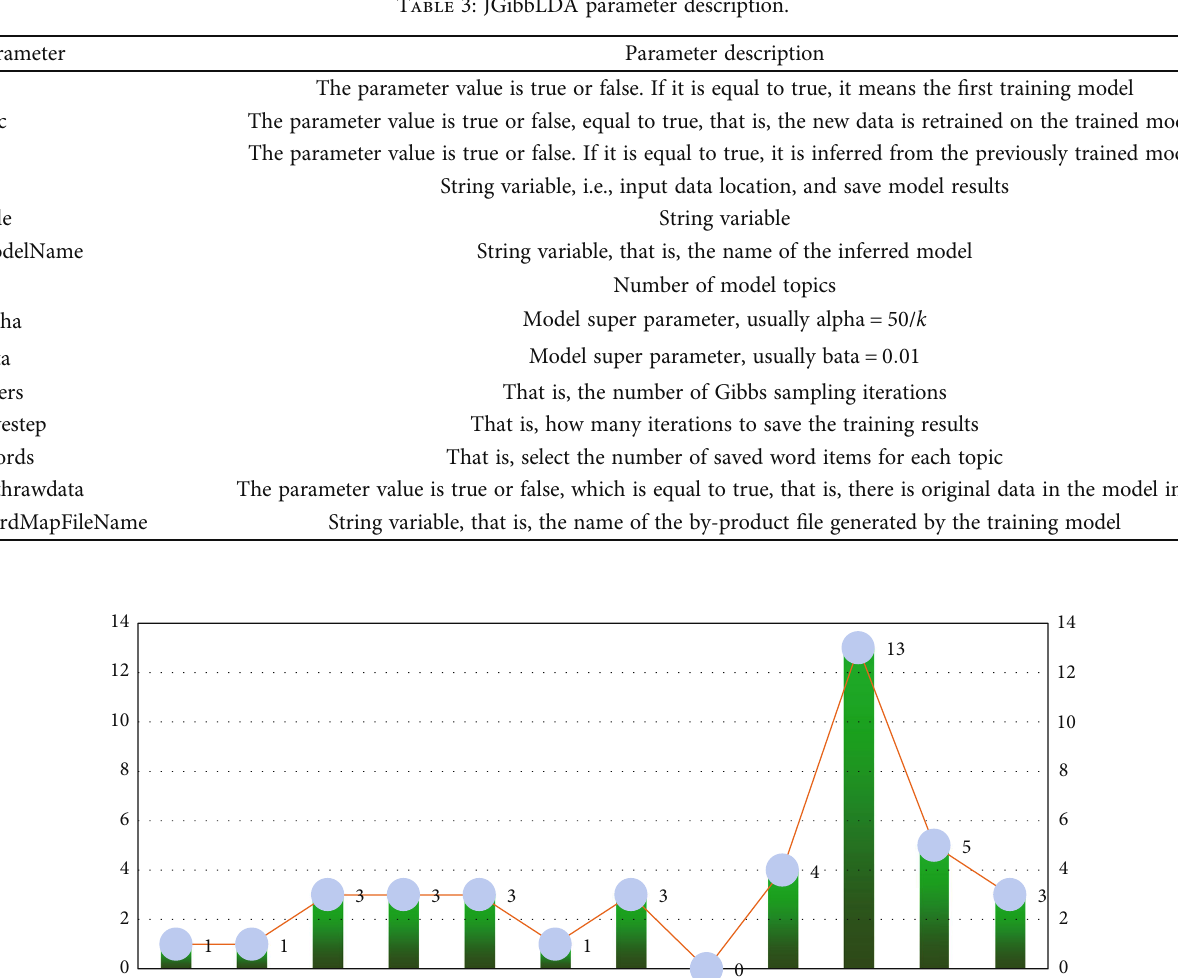
Table 3: JGibbLDA parameter